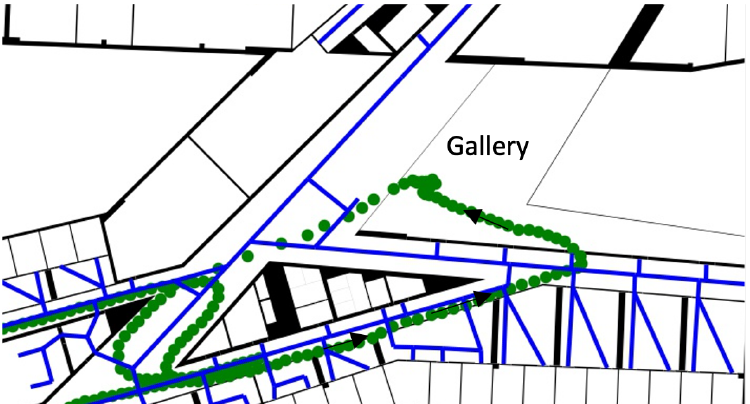
Figure 10. Part of the trajectory of the eight path, that wrongly proceeds in the “gallery”, when using the weighting by routing support method, where black arrows indicate the walking direction and the green points represent the position estimates for each